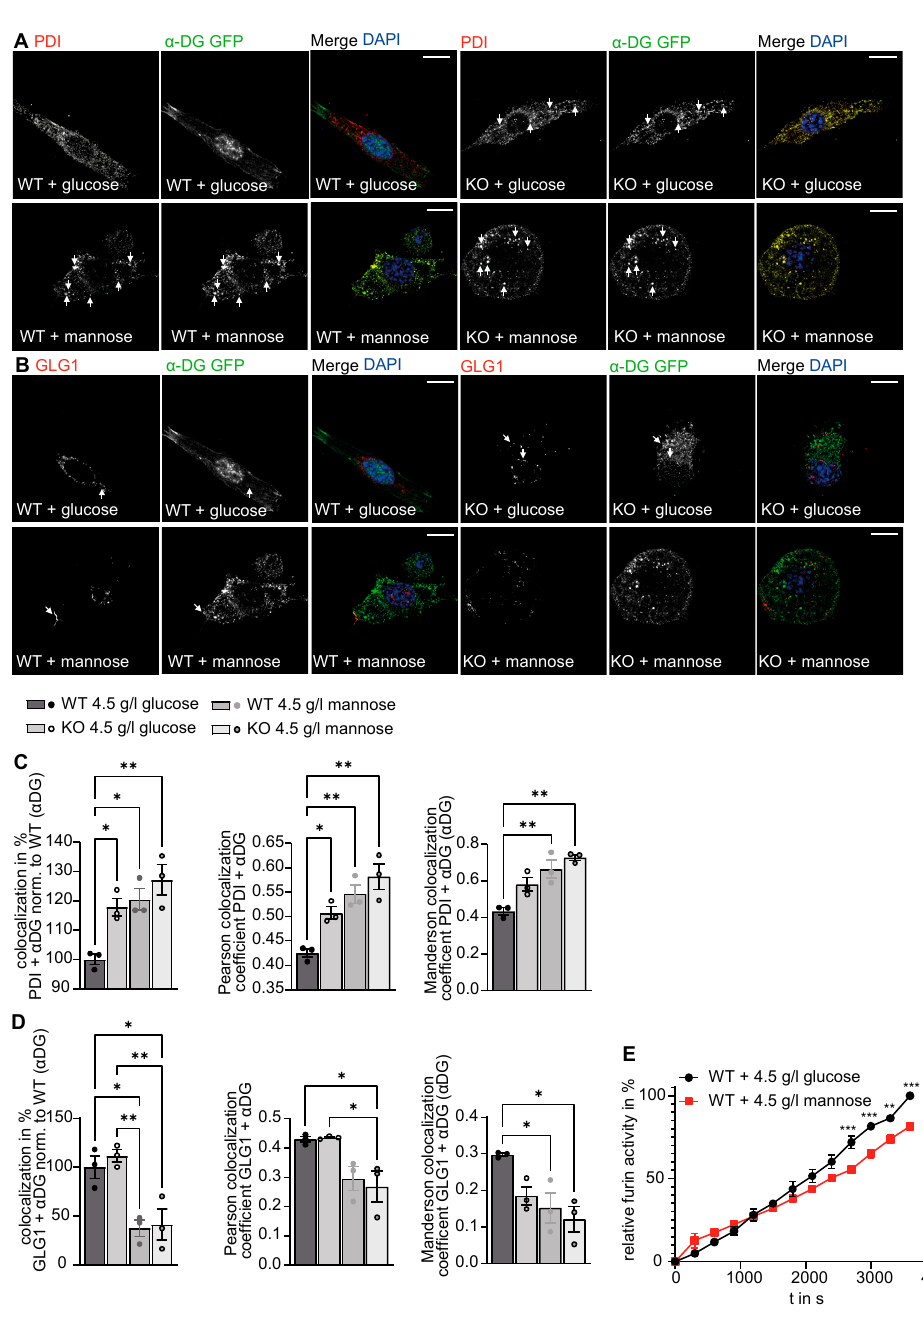
GMPPA KO MEFs stained for GM130 and TGN38 upon treatment with 4.5 g/L glucose or mannose (scale bars: 8 µ m). White arrows indicate co-localized structures. ( C ) ImageJ analysis (ComDet plugin) for particle numbers and colocalization (n = 3 experiments per group, 9 images per genotype and treatment per experiment). ( D ) Representative images of WT and GMPPA KO MEFs stained for CLIMP63 and RTN4 upon treatment with either 4.5 g/L glucose or mannose (scale bars: 8 µ m). White arrows indicate colocalized structures. ( E ) ImageJ analysis (ComDet plugin) for particle numbers and colocalization (n = 3 experiments per group, 2-way-ANOVA with Bonferroni post-hoc analysis). * indicates p < 0.05, ** p < 0.01, and *** p < 0.001, **** p < 0.0001.